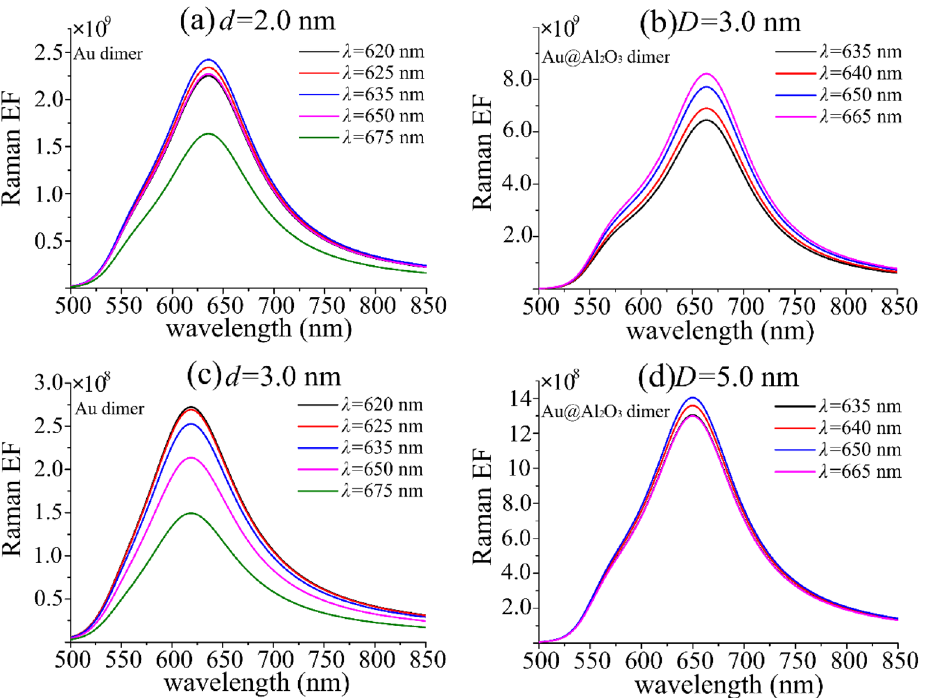
Figure 7. ( a , c ) and ( b , d ) respectively represent the comparison of Raman enhancement factor curves of Au and Au@Al 2 O 3 dimers with different excitation wavelengths at different distances, with a radius of 50 nm and incident light angle of 0°. The distance between Au@Al 2 O 3 dimer is set as d = 1 nm, and the thickness of Al 2 O 3 shell is r 0 = 1 nm and 2 nm respectively, so the distance between Au@Al 2 O 3 dimer Au core is D = 3 nm and 5